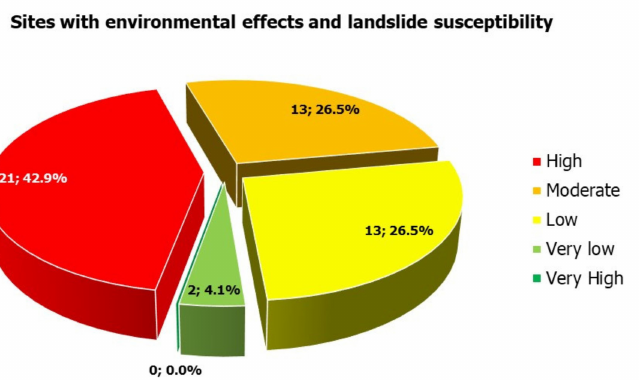
Figure 18. Pie chart showing the distribution of sites affected by slope failures triggered by the 12 August 1953 mainshock and its foreshocks on 9 and 11 August in zones of landslide susceptibility in the affected southern Ionian